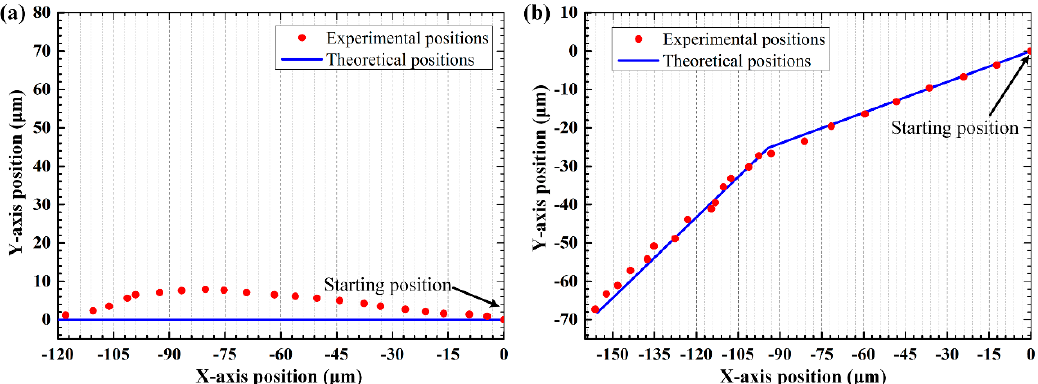
Figure 14. The theoretical and experimental center positions of the silica rod in each moving step ( a ) Along the trajectory indicated in Figure 13a; ( b ) Along the trajectory indicated in Figure 13b.